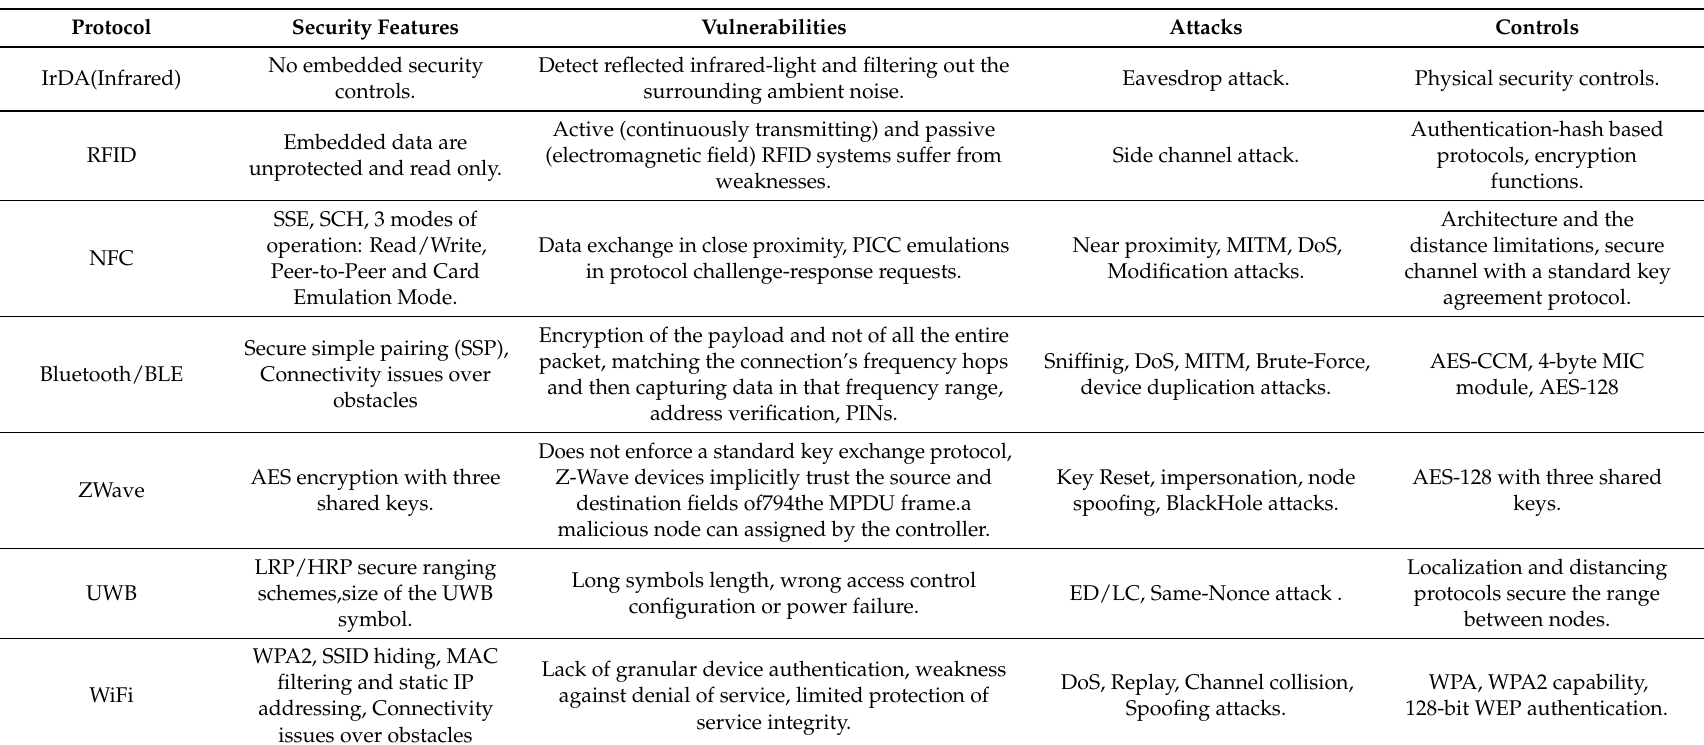
Table 5. IoMT protocols security features, vulnerabilities, attacks and possible